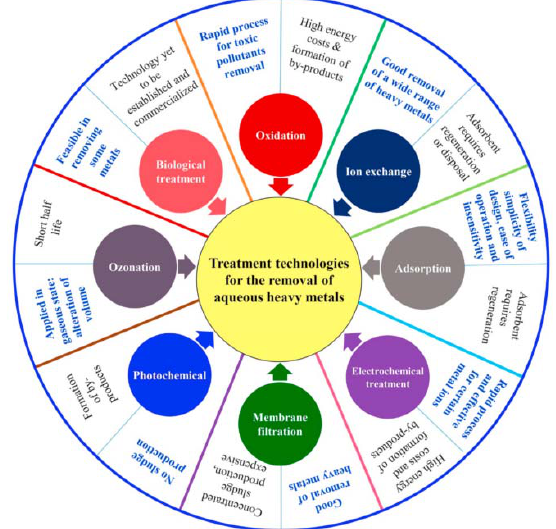
Figure 1. Main characteristics of methods for heavy metal removal. Reprinted with permission from Ref. [28]. 2022, Elsevier .